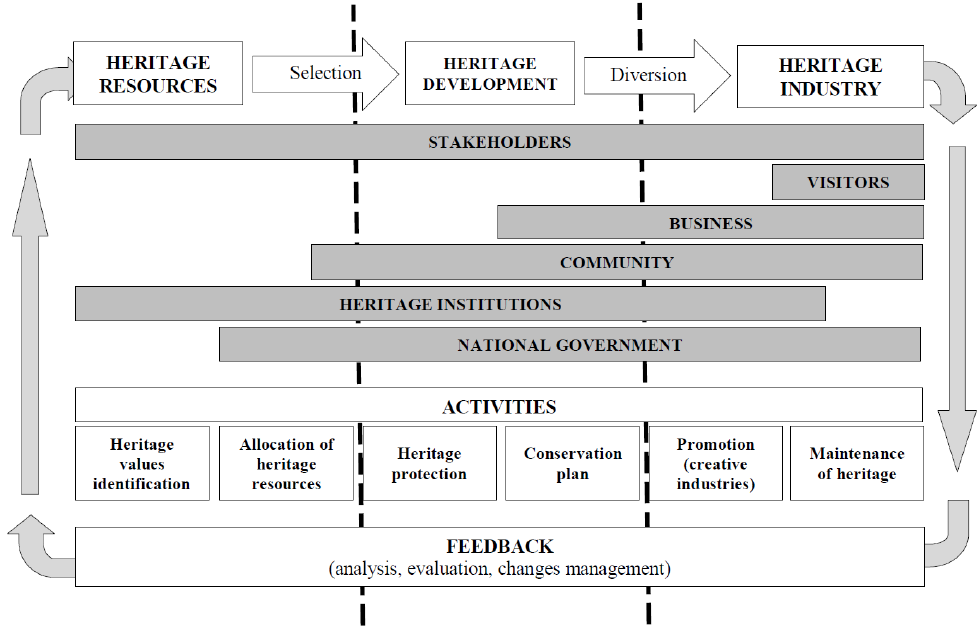
Figure 18. Lithuanian heritage management model . Source: Radzevi č ius and Jur ė nien ė (2014). Soviet Heritage and Tourism Development: The Case of Lithuania. Інтелект XXI № 2, p. 38.